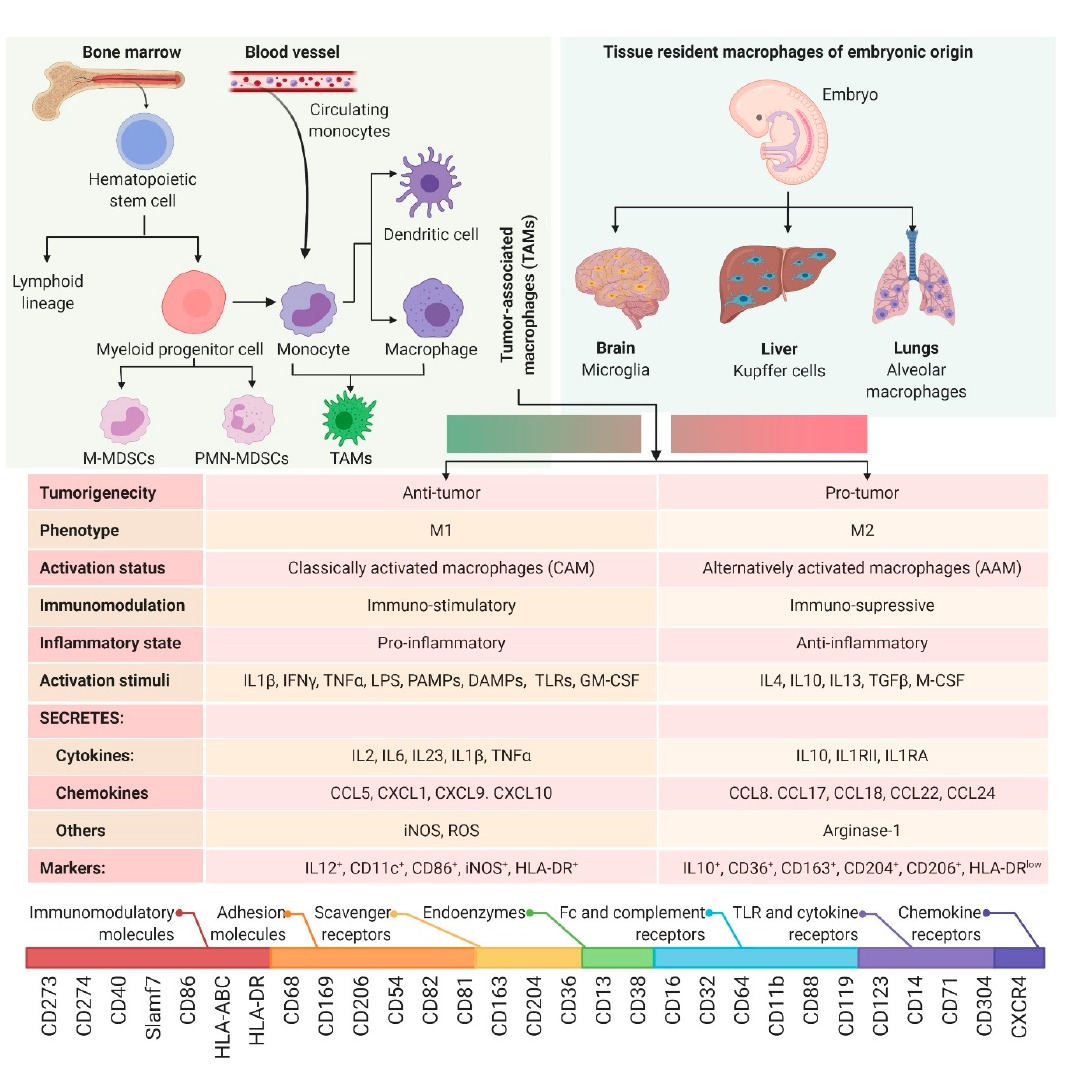
Figure 2. Ontogeny of macrophages. Top panel (left): Sources of macrophage recruitment, namely bone marrow and circulating monocytes; top panel (right): Various types of tissue resident macrophages; middle table: Characteristics of macrophage dichotomy; bottom: The spectrum of surface markers used to phenotype macrophages. Abbreviations: CAM: Classically activated macrophages; AAM: Alternatively activated macrophages; M-MDSC: Monocytic myeloid-derived suppressor cell; PMN-MDSC: Polymorphonuclear/granulocytic myeloid-derived suppressor cell; IL: Interleukin; IFN: Interferon; LPS: Lipopolysaccharide; PAMPs: Pathogen-activated molecular patterns; DAMPs: Damage-associated molecular patterns; TLR: Toll-like receptor; TNF: Tumor necrosis factor; CSF: Colony-stimulating factor; GM-CSF: Granulocyte-macrophage colony-stimulating factor; TGF: Transforming growth factor; iNOS: Nitric oxide synthase (inducible); ROS: Reactive oxygen species; CCL: Chemokine ligand; CXCL: C-X-C motif chemokine ligand; CD: Cluster of differentiation; HLA: Human leukocyte antigen; Slamf7: Signaling lymphocytic activation molecule F7.